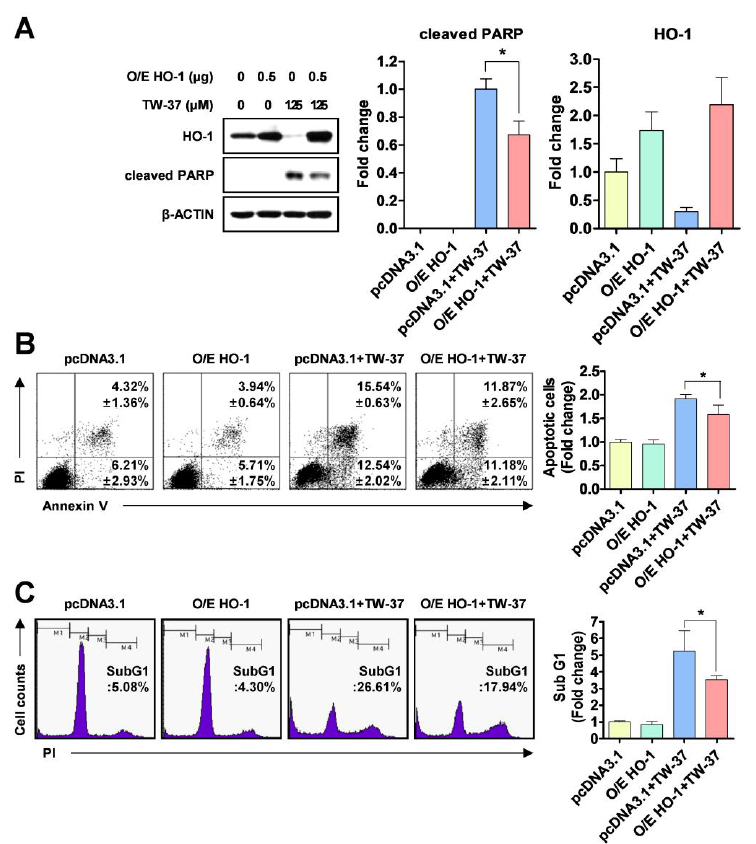
Figure 3. Blockade of TW-37-induced apoptosis by ectopic expression of HO-1. YD-15 cells were transiently transfected with pcDNA3.1 or pcDNA3.1-HO-1 for 6 h, and then treated with DMSO or TW-37 for 48 h. ( A ) Protein levels of HO-1 and cleaved PARP were analyzed by western blotting. Actin was used as a loading control. Bar graphs are expressed as mean ± SD from three independent experiments. *, p < 0.05. ( B ) FACS analysis of annexin V/PI staining. The annexin V-positive cells are expressed as the percentage of apoptotic cells. The results are expressed as mean ± SD from three independent experiments. *, p < 0.05. ( C ) FACS analysis of PI staining. The histogram represents the distribution of the cell cycle and the percentage of cells in the sub-G1 phase are expressed as mean ± SD from three independent experiments. *, p < 0.05.